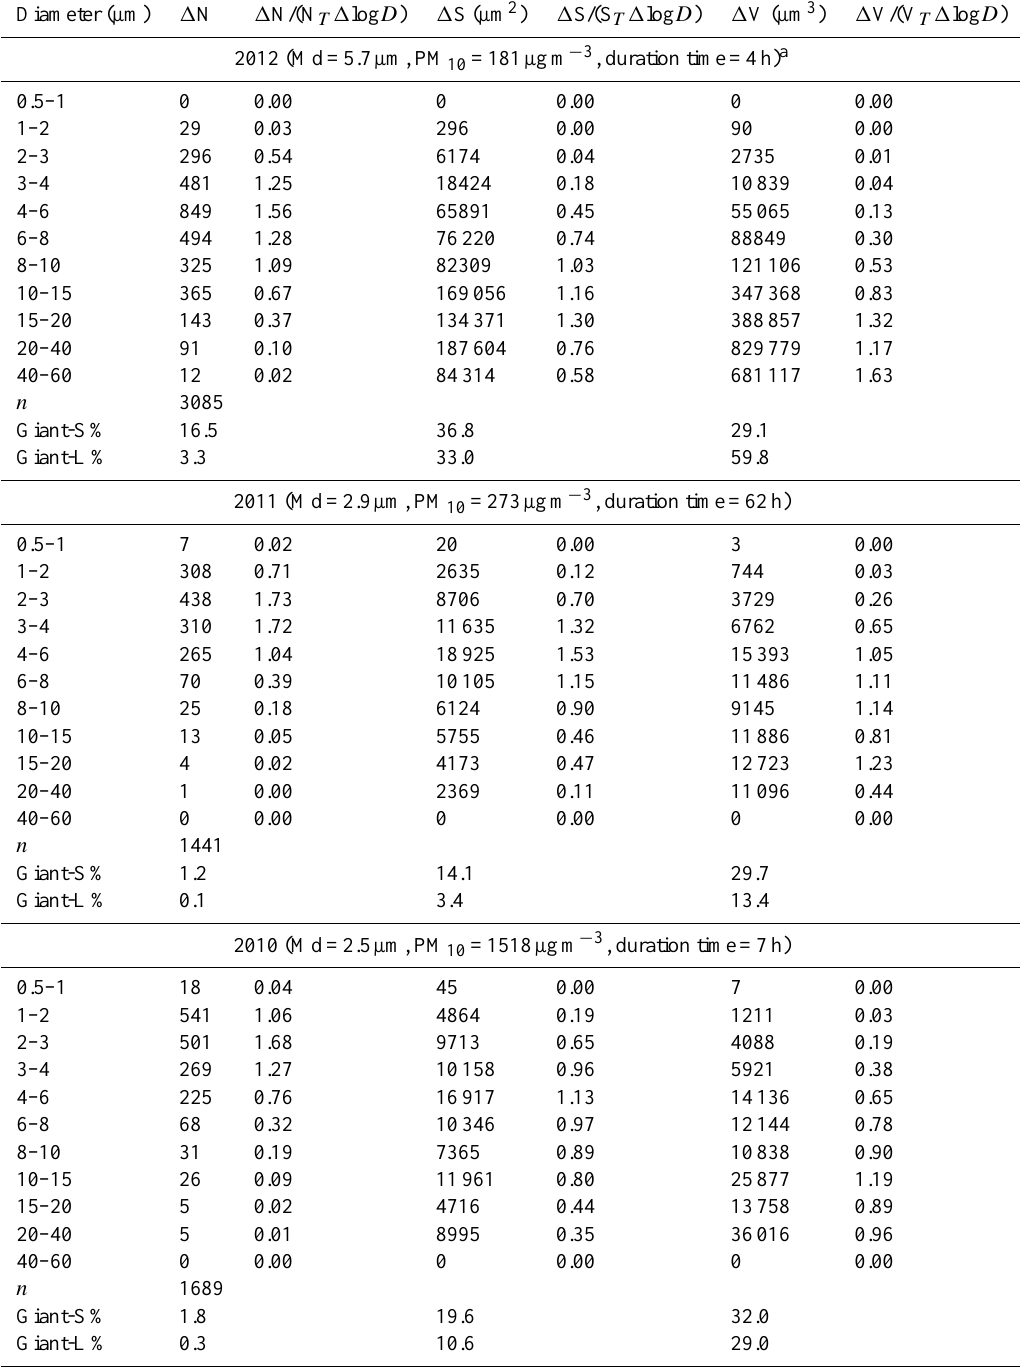
Table 1. Particle number, surface area, and volume distribution of three Asian dusts from SEM measurements with basic properties. Diameter